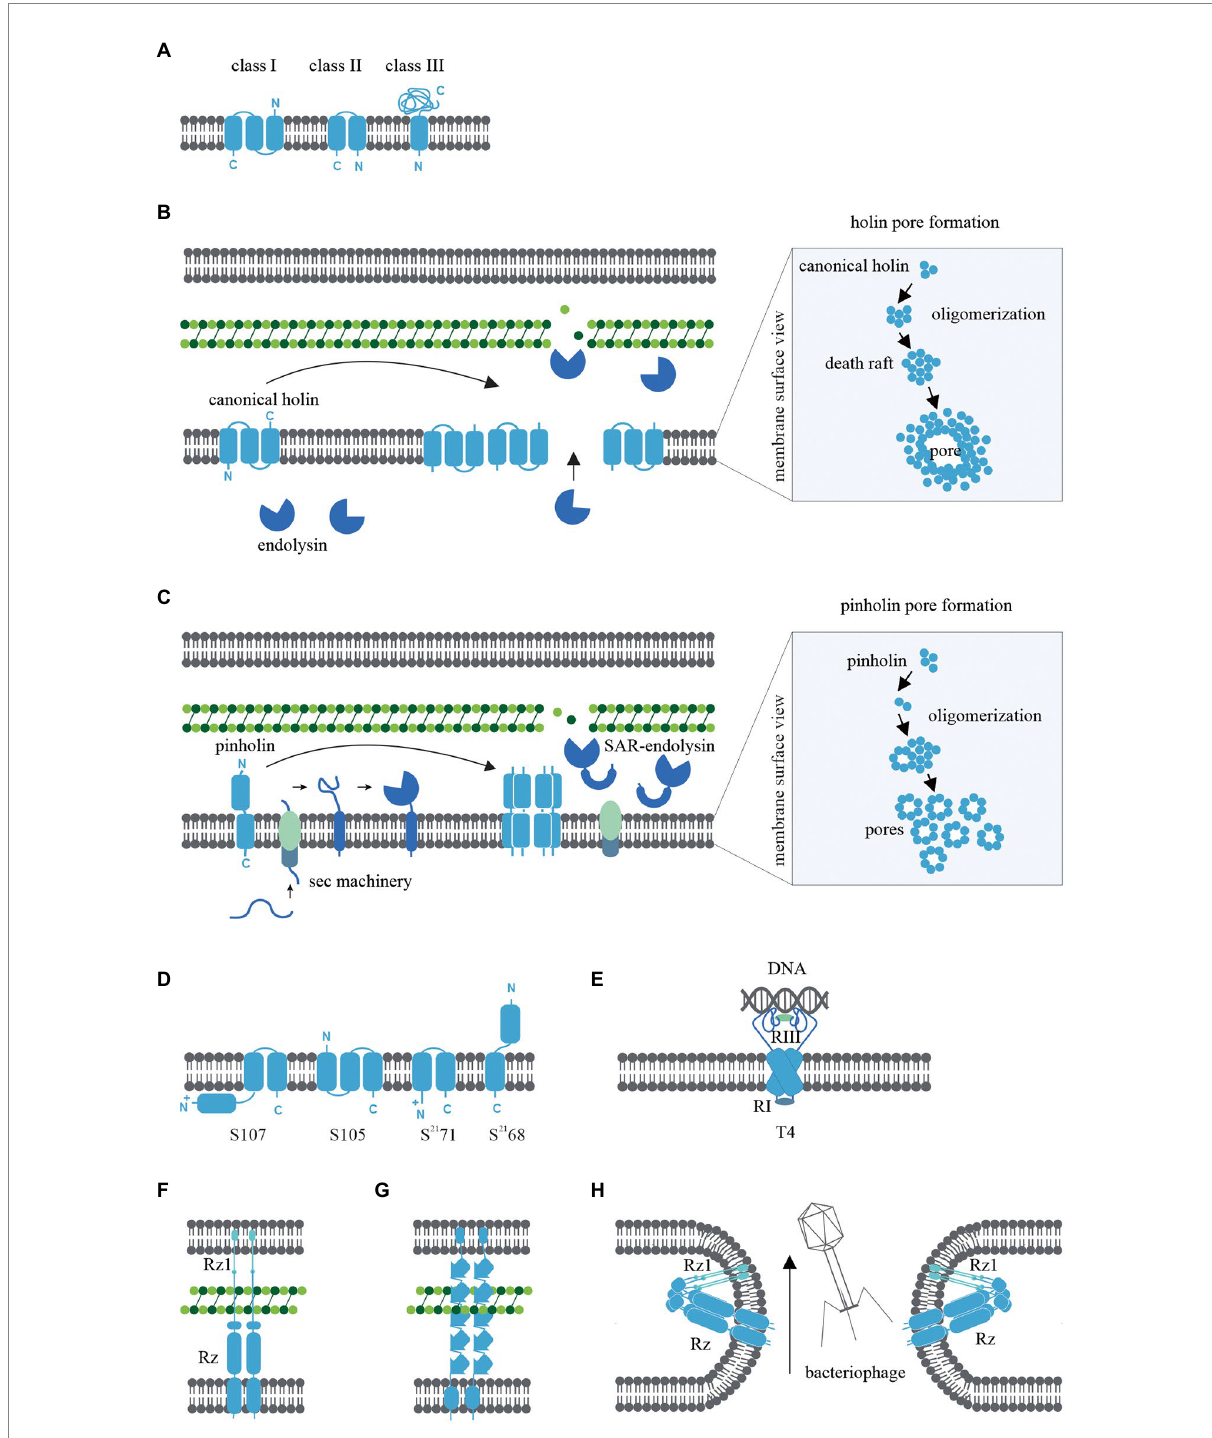
FIGURE 1 (A) Transmembrane α -helical segment topology of the most studied holin classes (I-III). (B) Schematic representation of canonical pathway: Following the late gene expression initiated in the bacteriophage lytic cycle, canonical holins and endolysins accumulate in the inner membrane and cytoplasm, respectively. At an allele-specific time, holins make micron-scale holes in the inner membrane and endolysins escape to the periplasm, degrading the peptidoglycan. (C) Schematic representation of pinholin pathway: When late gene expression is initiated, pinholins and inactive SAR endolysins accumulated in the inner membrane. At an allele-specific time, pinholins make heptameric channels with a lumen of ~2 nm which destabilised the proton motive pump. SAR endolysins transform into their active form as they are sensitive to the proton motive pump and finally degrade the peptidoglycan. (D) Topology of lambda and lambdoid bacteriophage ϕ 21 holins (S105, S 21 68) and its antiholins (S107, S 21 71). (E) T4 holin complex can make a complex with its RI, RIII antiholins, and DNA to respond to superinfections. (F) Two-component spanins (G) Unimolecular spanins (H) Fusion inner and outer